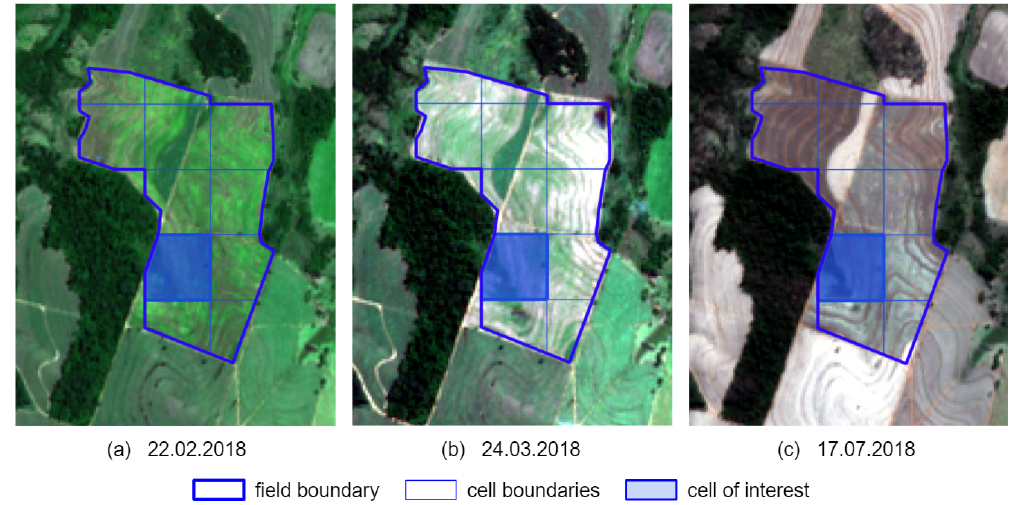
Figure 22. Example of the parcel with nonagricultural vegetation (cid = 163): ( a ) before harvest; ( b ) partial harvest; ( c ) completely harvested parcel.